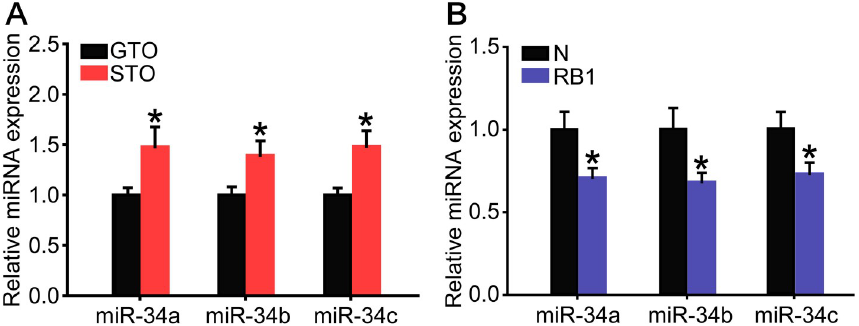
Fig 5. The expression levels of three miR-34 isoforms in the GTO and STO (A) or in the N and RB1 (B). (A) n = 12–15. (B) n = 6–8. � P < 0.05.